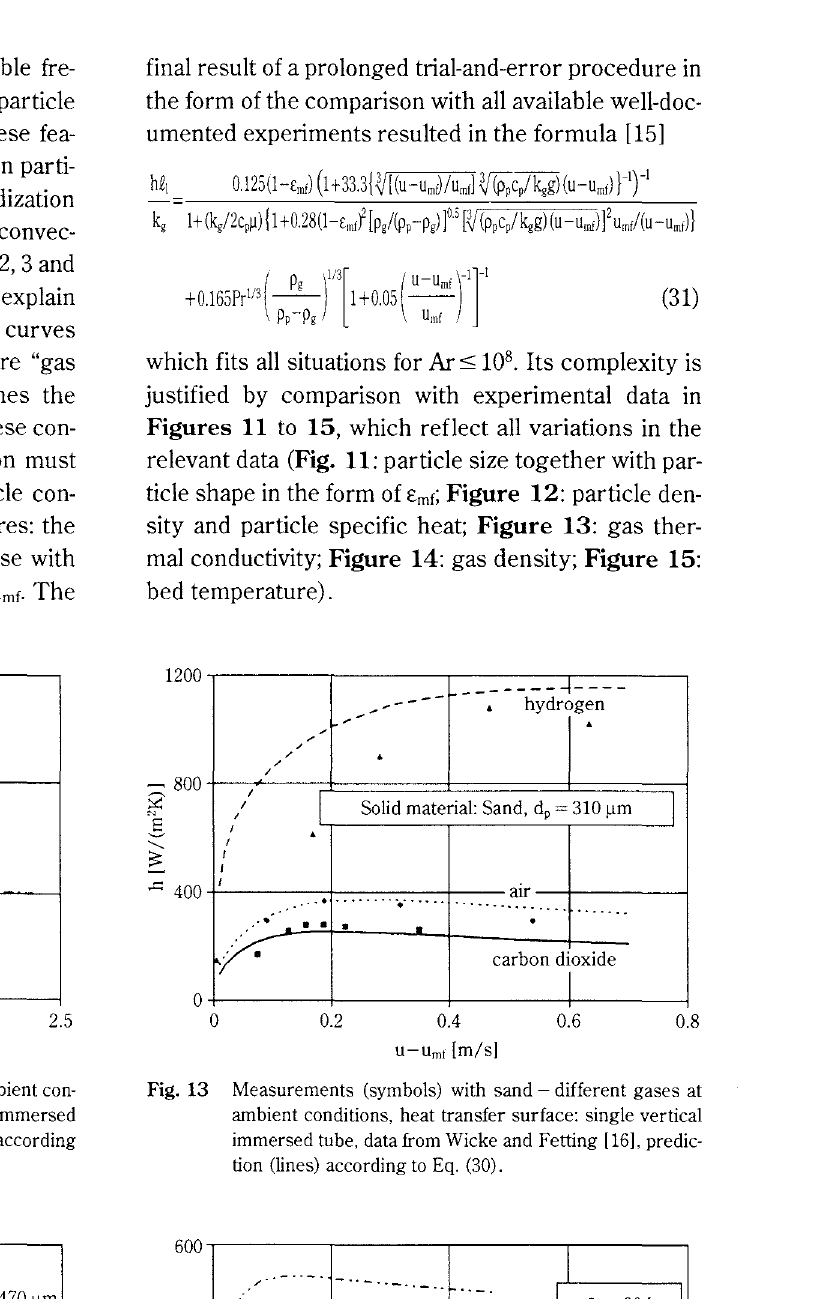
Fig. 11 Measurements (symbols) with mullite-air at ambient con· ditions, heat transfer surface: single vertical immersed tube, data from Wunder [2], prediction (lines) according to Eq. (30)